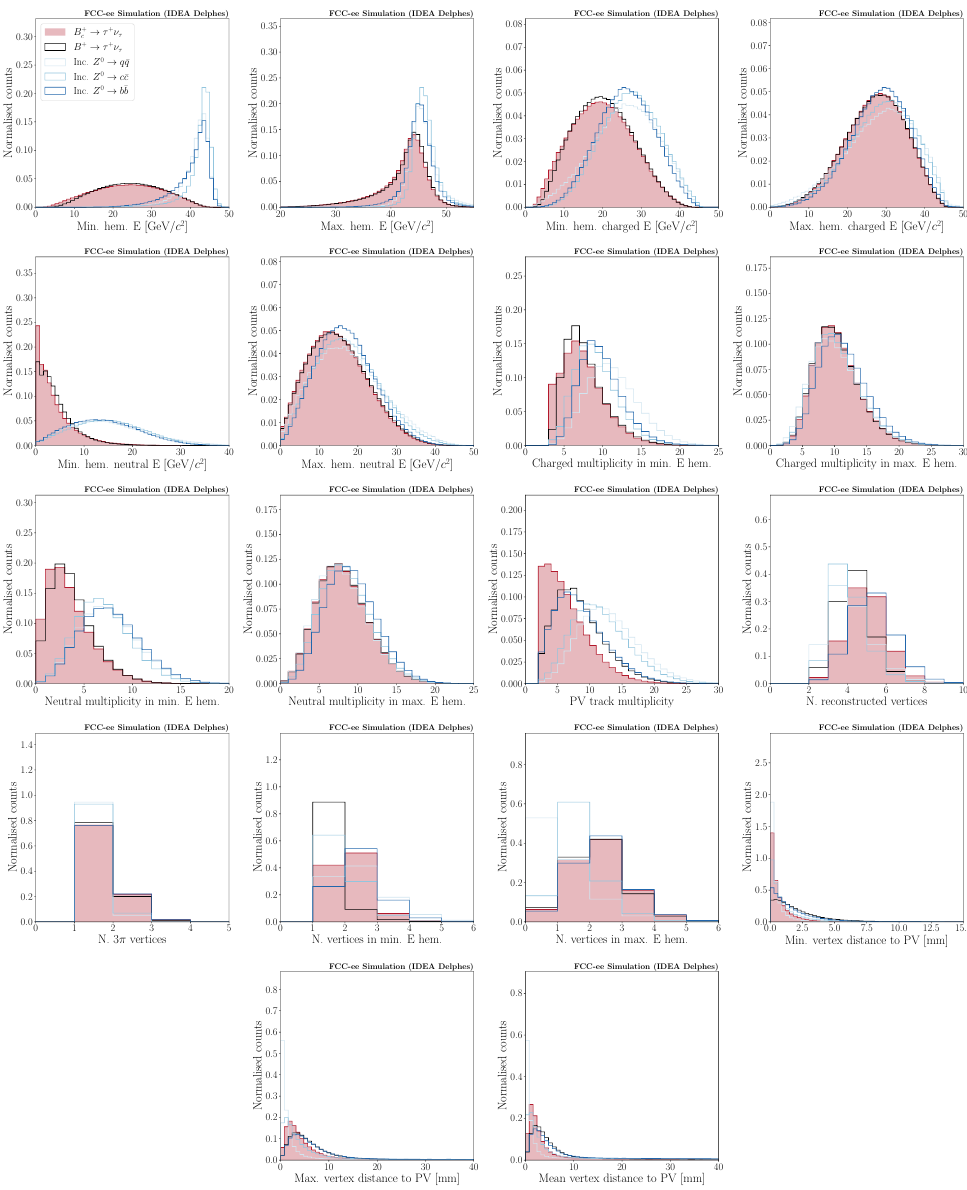
Figure 12 . First-stage BDT training variable distributions in signal, B + → τ + ν τ background, and inclusive Z 0 → q ¯ q, c ¯ c, b ¯ b